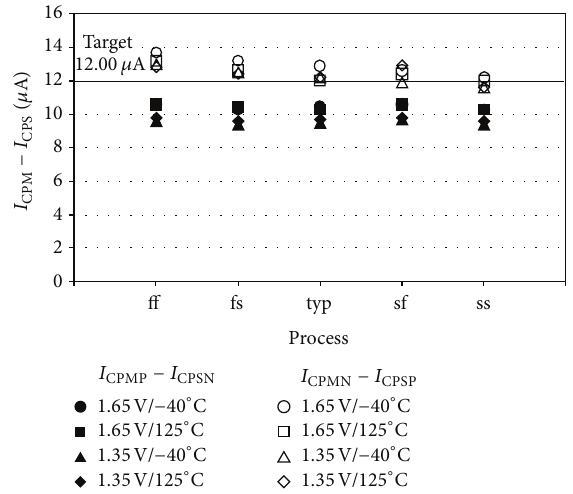
− 𝐼 , CPMP CPSN ( 𝐼 and 𝐼 ) CPM CPMP CPMN